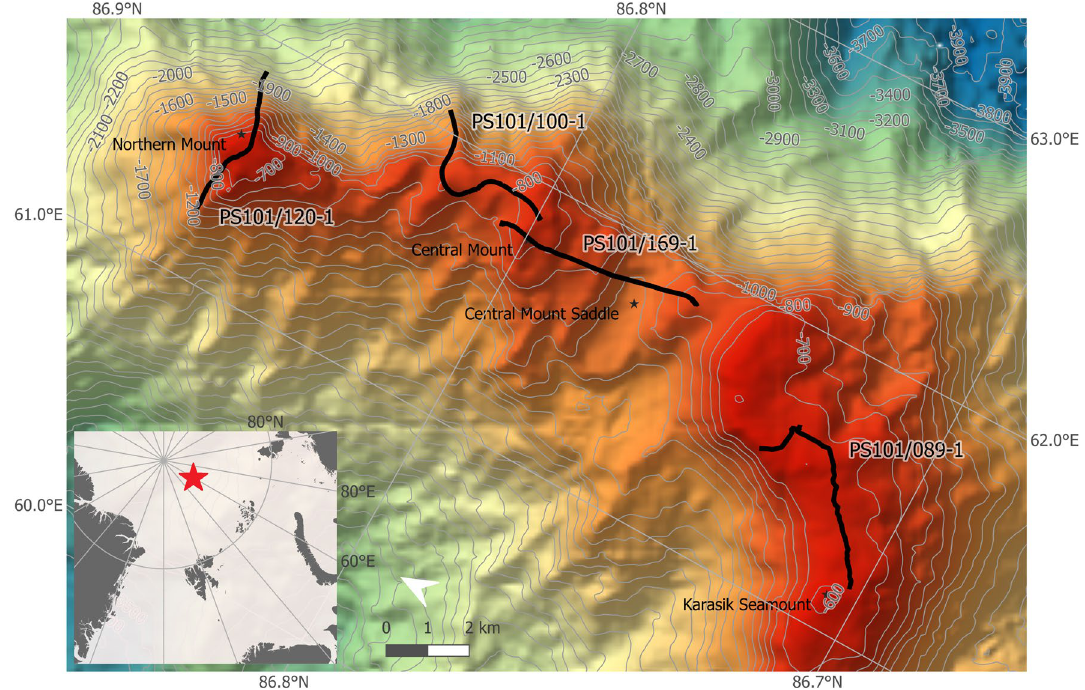
Figure 7. Map of the Northern Mount, Central Mount, and Karasik Seamount along the Langseth Ridge with all Ocean Floor Observation and Bathymetry System (OFOBS) deployments. The station numbers correspond to the OFOBS transect numbers in Table S7. The map was created using ArcGIS software, version 10.5 (https:// www. arcgis.